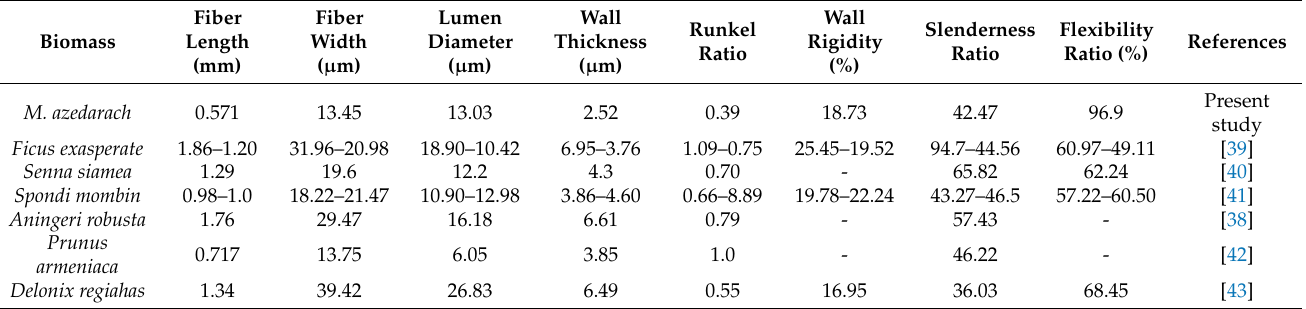
Table 2. The mean values of M. azedarach fiber dimensions compared with other papermaking biomass